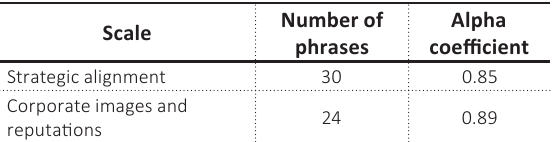
Table 2. Cronbach’s alphas for measures